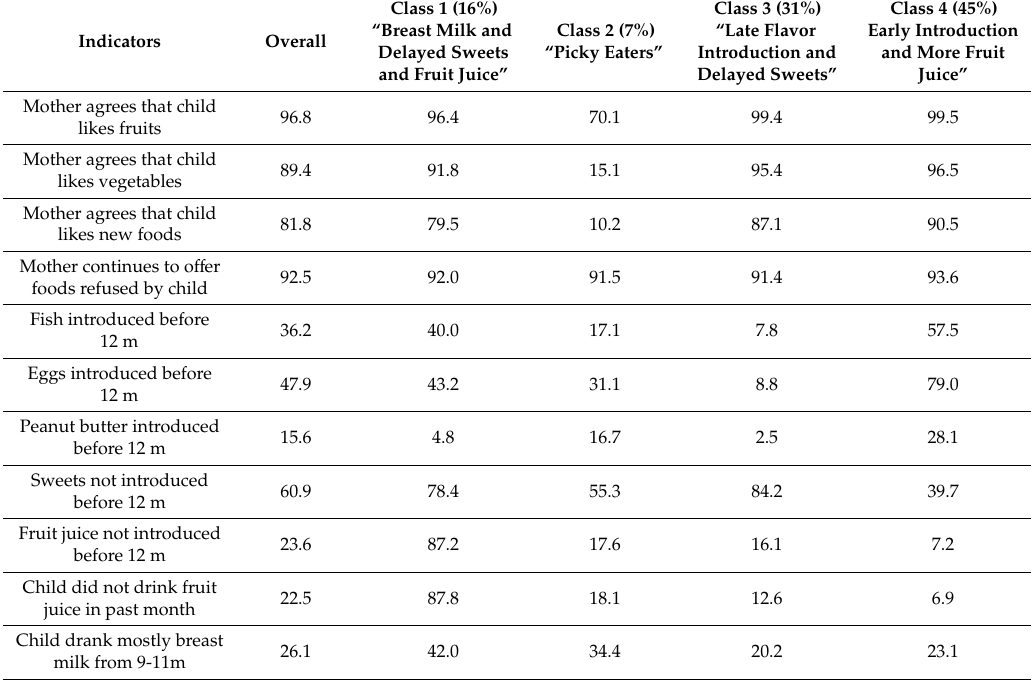
Table 1. Sample proportions in each class and overall and class-specific response probabilities 1 for latent class indicators measured at ~1y, among 1162 Project Viva participants. Class 1 (16%) Class 2 (7%) “Breast Milk and Indicators Overall “Picky Delayed Sweets and Fruit Juice”